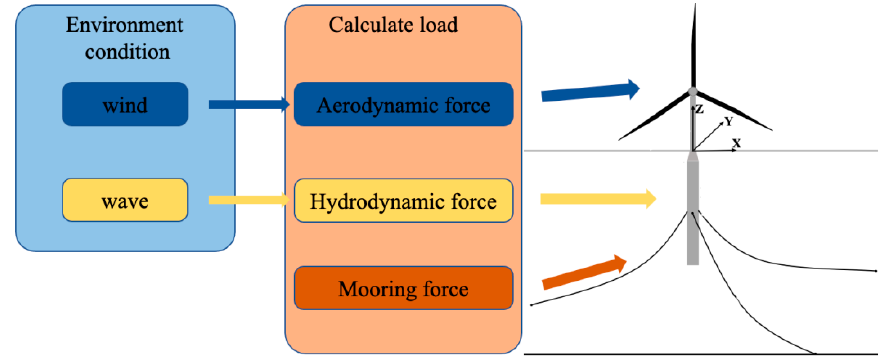
Figure 3. Flow chart for floating wind turbine dynamic response analysis.